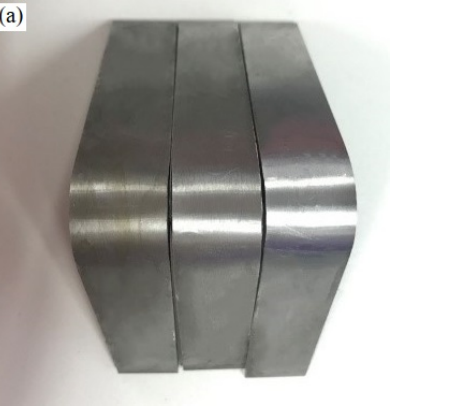
Table 4. Hardness of BF and GB of the welded joint.